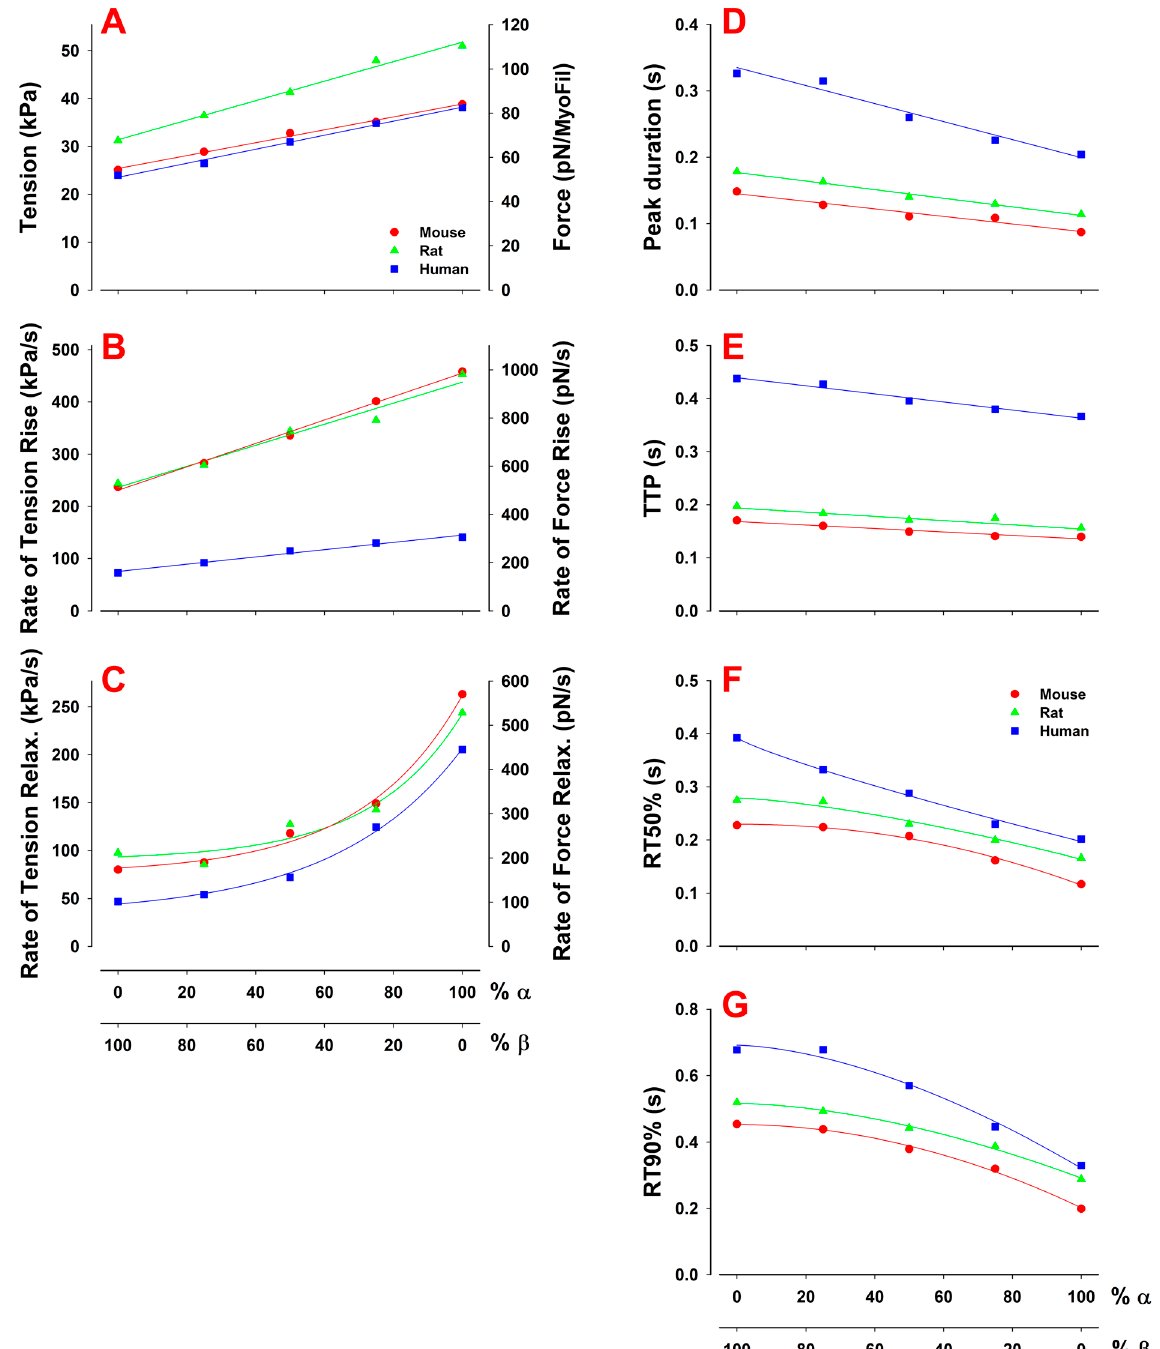
Figure 5. Effects of fractions of α - vs. β -isoforms on twitch characteristics. Parameters plotted are ( A ) peak tension (PT), ( B ) rates of tension rise and ( C ) relaxation, defined as a slope between 30 and 75% of the PT during the rise and vice versa during relaxation, ( D ) peak duration, defined as the time during which the tension is above 90% of the PT, ( E ) TTP, defined as the time from the onset of twitch contraction till the tension reaches the peak, ( F ) RT50% and ( G ) RT90%, defined as the time intervals from the time when the PT is reached to the times at which the tension relaxes to 50% and 90% of the PT, respectively. The magnitude of the peak tension and the rate of tension rise approximately linearly increased with the increase of α -isoform fraction, while the peak duration and TTP linearly decreased as the % α increased. The rate of tension relaxation nonlinearly increased while the RT50% and RT90% nonlinearly